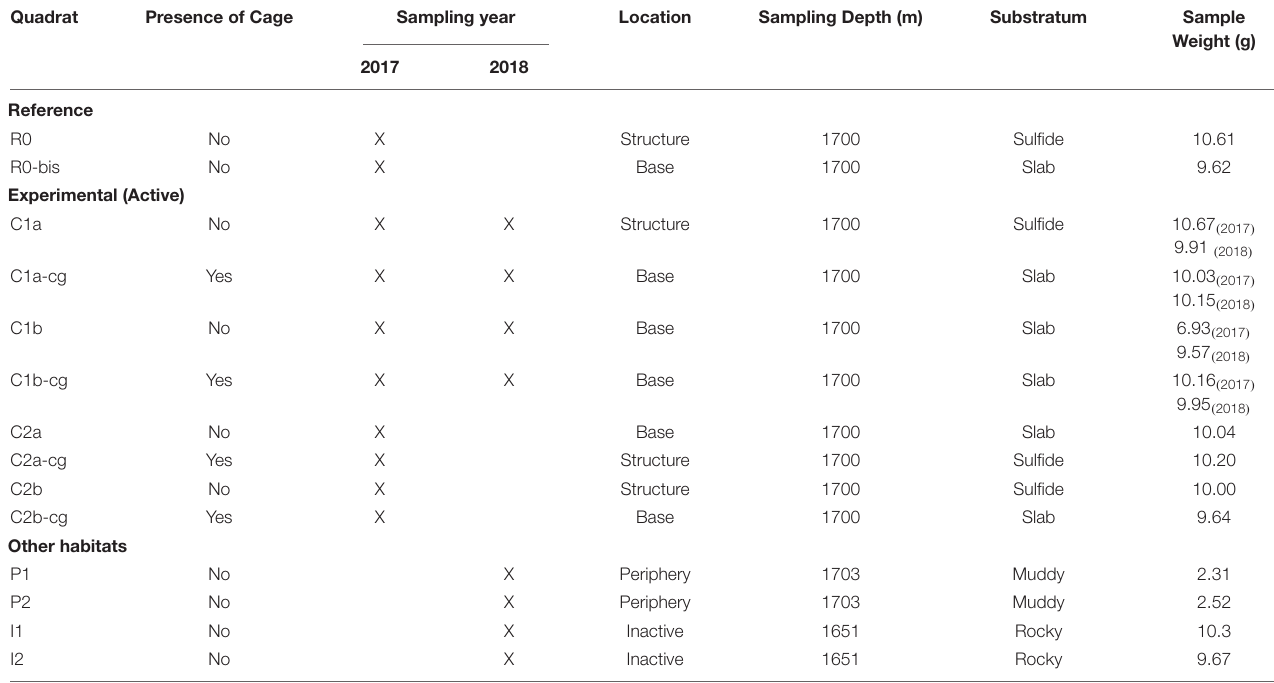
TABLE 1 | Details of each substratum sample obtained from the in situ experiment that was deployed on and at the base of the Montségur edifice, as well as at the peripheric and inactive habitats.